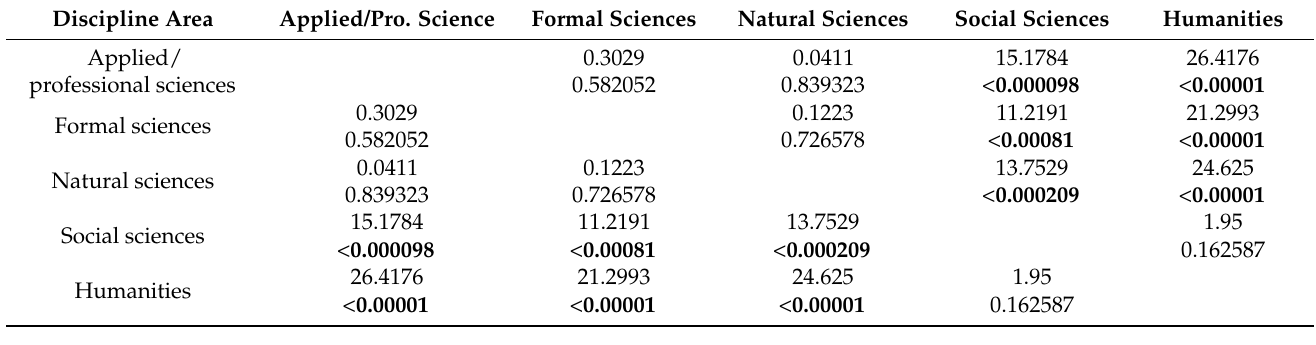
Figure 11. Comparison of institution type responses of P&T cases where faculty members’ I&E were considered at their institutions. Table 3. Chi-square statistic/ p -value from chi-square tests of independence between respondents claims of evaluation of faculty I&E in P&T at their institutions across five discipline areas; degrees of freedom = 1; significance at p < 0.01. Bolded text equates to a significant difference.